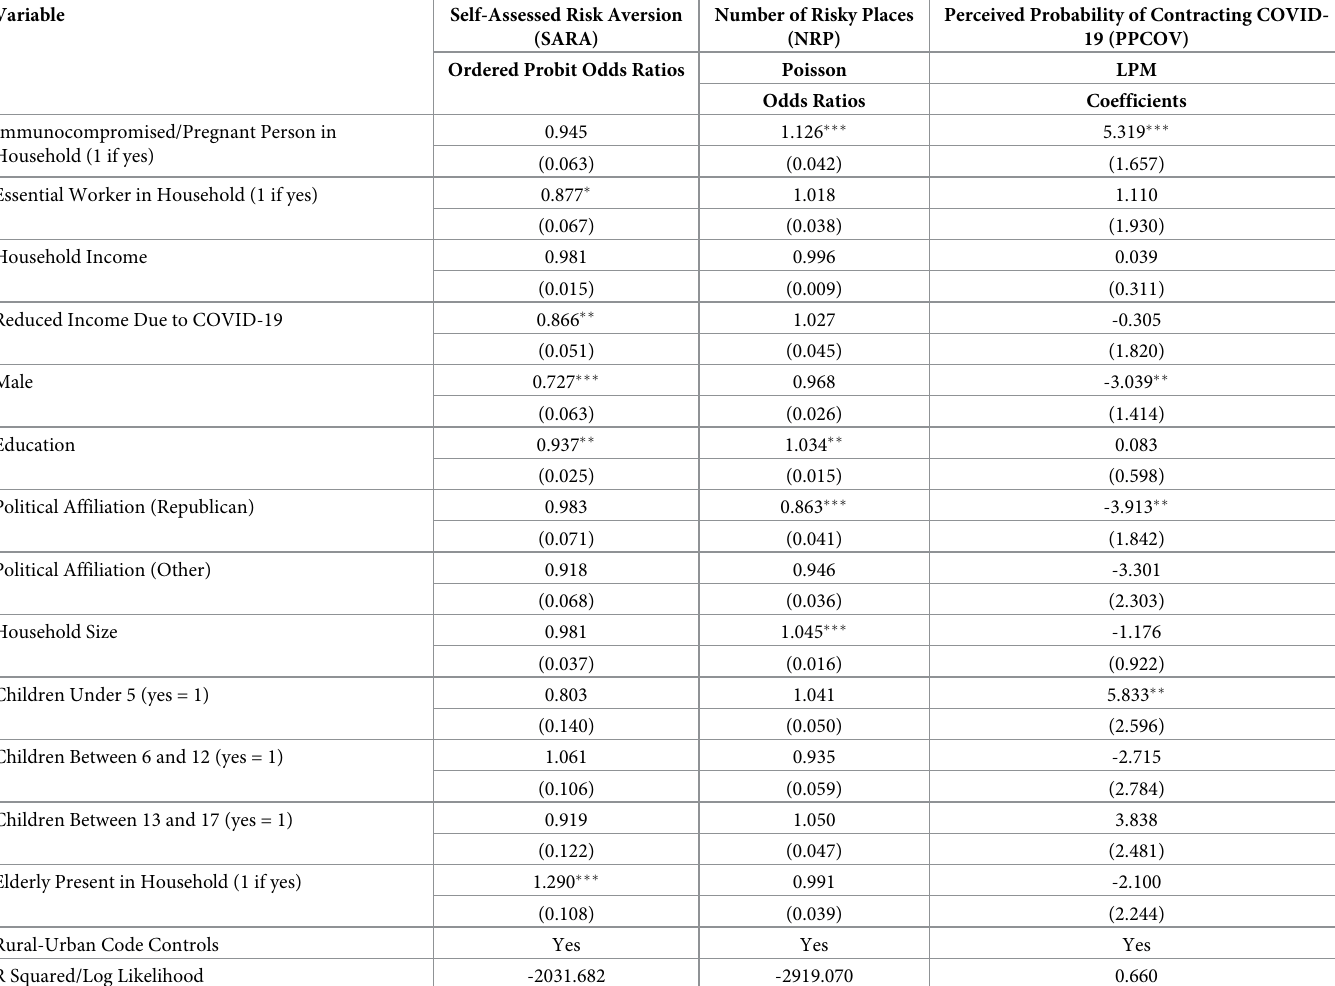
Table 3. Factors correlated with the three risk